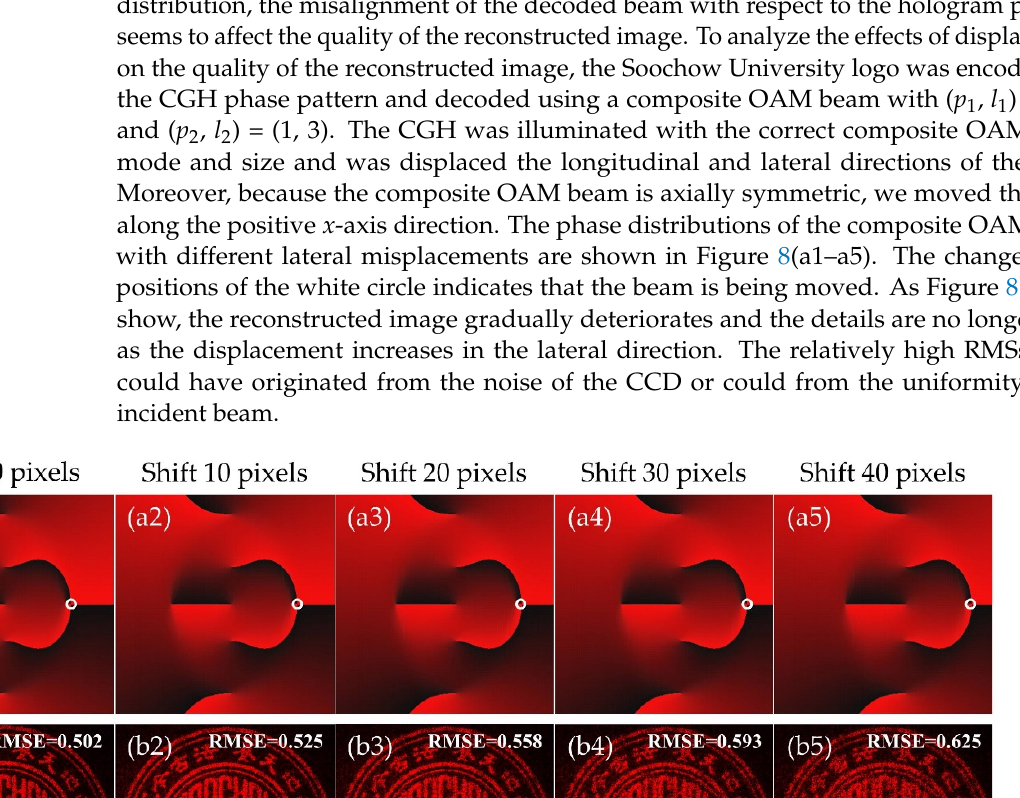
Figure 7. Experimental results of the CGH encoding grayscale image of a tiger. ( a ) The correct il- lumination of design was ( p 1 , l 1 ) = (1, 1) and ( p 2 , l 2 ) = (1, 3). The wrong illuminations used were ( b ) ( p 1 , l 1 ) = (0, 1) and ( p 2 , l 2 ) = (0, − 1), ( c ) ( p 1 , l 1 ) = (0, 3) and ( p 2 , l 2 ) = (0, − 3), and ( d ) ( p 1 , l 1 ) = (1, 1) and ( p 2 , l 2 ) = (1, − 3).